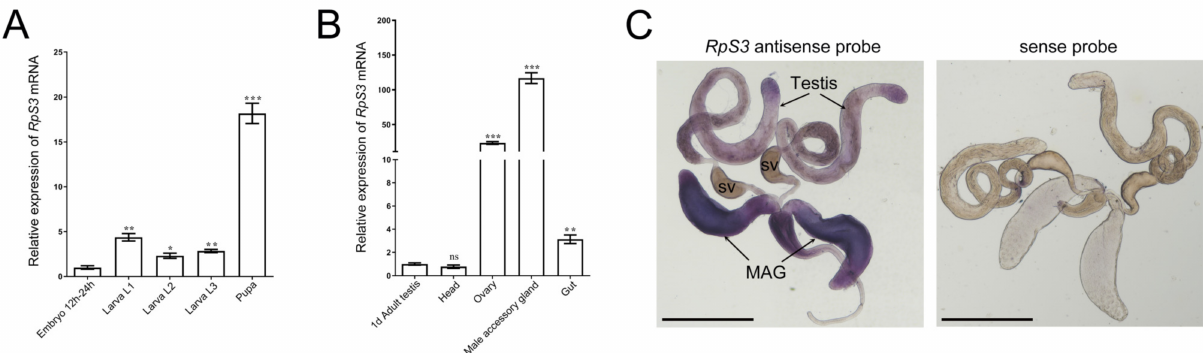
Figure 1. The temporal and spatial expression pattern of RpS3 in Drosophila . ( A , B ) The RpS3 mRNA expression levels at different developmental stages ( A ) and in different adult organs ( B ) were quanti- fied by qRT-PCR. * p < 0.05, ** p < 0.01, *** p < 0.001, ns: no significance. ( C ) The RpS3 expression pattern in male reproduction system by in situ hybridization. The sense probe was used as a negative control. MAG, male accessory gland; sv, seminal vesicle. Scale bars in ( C ) 500 µ